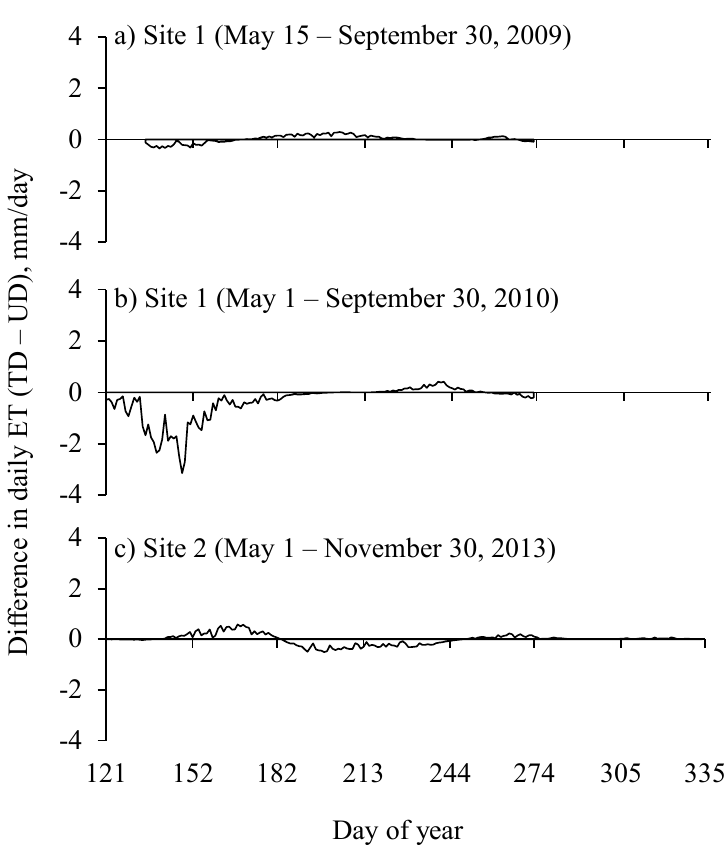
Figure 5. Daily ET differences (TD–UD) at ( a , b ) Site 1 and ( c ) Site 2. The positive values indicate greater ET rates from the TD fields. Corn ET (Site 1) after October 1 to end-November, 2009 is missing due to unavailability of cloud-free Landsat image.